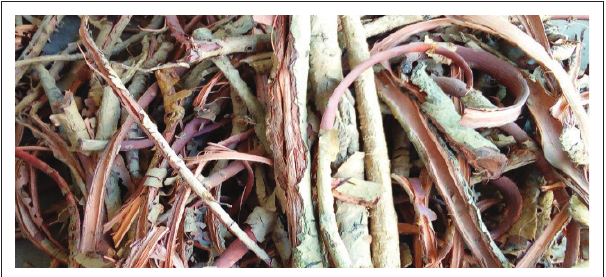
FIGURE 3: Root bark of Calophyllum inophyllum